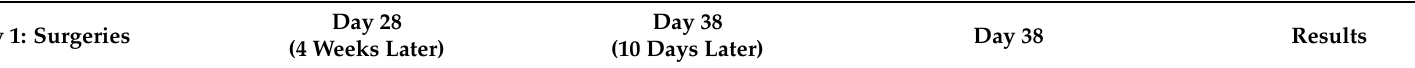
Table 4. Experimental design flow chart depicting animal grouping and sequence of the main procedures in the section describing the effect of intensive trigeminal indirect stimulation, produced by its forced overuse due to excision of the contralateral infraorbital nerve (Ion) after surgery, on the buccal branch of the facial nerve on the degree of collateral axonal branching. Bn-n, transection and suture of the buccal branch of the facial